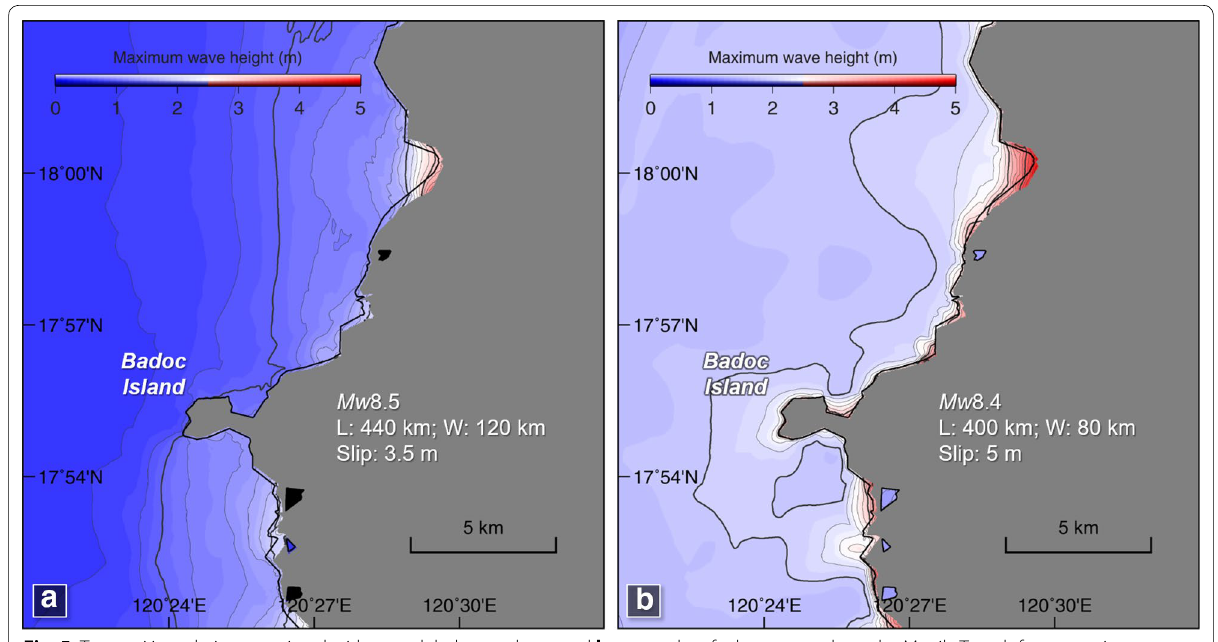
Fig. 5 Tsunami inundation associated with a modeled megathrust and b upper‑plate fault ruptures along the Manila Trench forearc region. Embayments and low‑lying areas in Ilocos Norte are observed to be affected by waves more than 3 m high. Minimum earthquake magnitudes are estimated from inferred source fault parameters and amount of slip calculated from fault scaling relations. Contours in bold lines represent 1‑m intervals. Note that the coastline resolution and extent of inundation are constrained by the resolution of the basemap